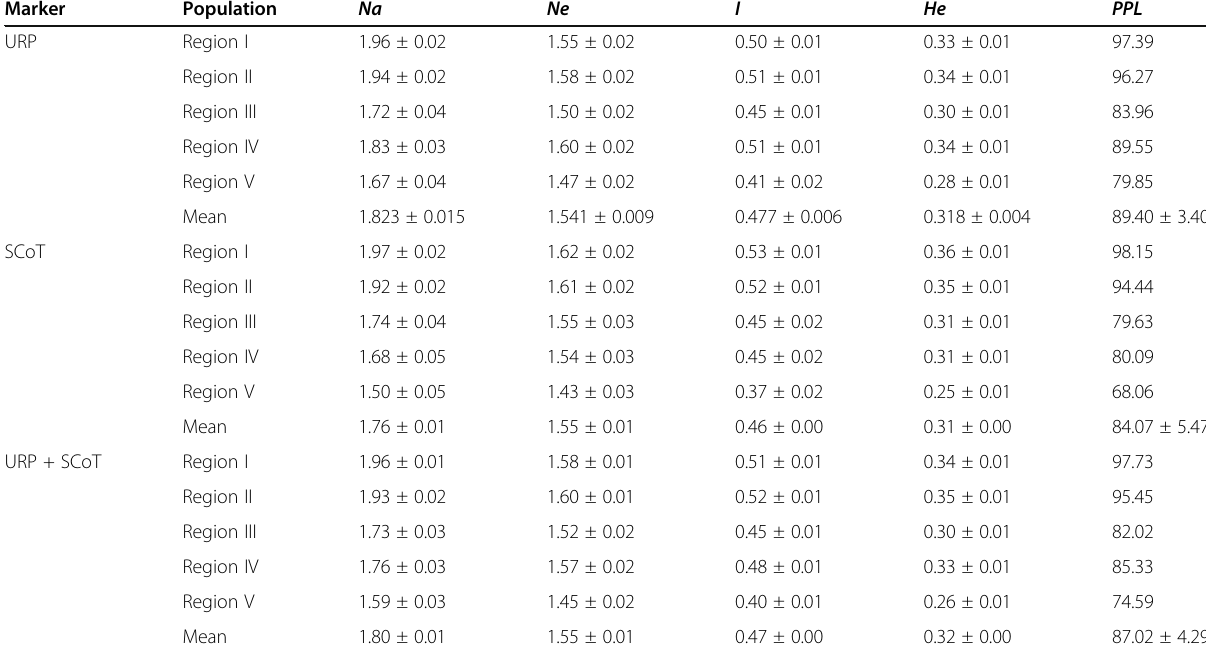
Table 4 Summary of genetic variation among different Iranian Rosa damascena Mill. populations as revealed through URP and SCoT analysis Marker